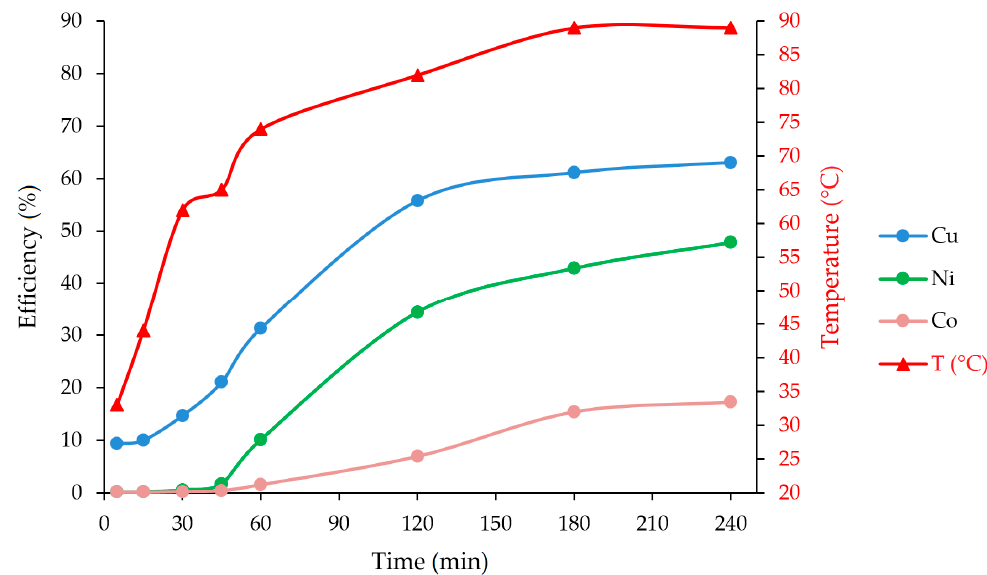
Figure 10. Kinetics of metals extraction during ammoniacal leaching with ultrasound and microwave (60 W).